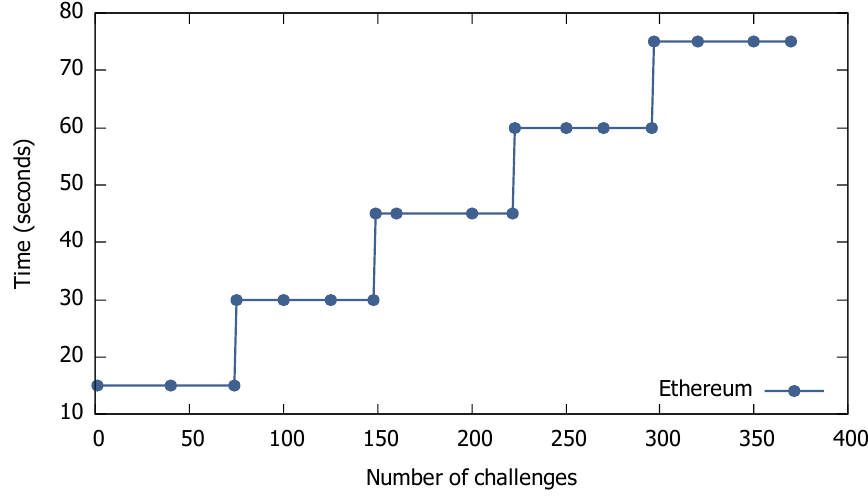
Figure 4. Time scalability for Ethereum-based scenarios.